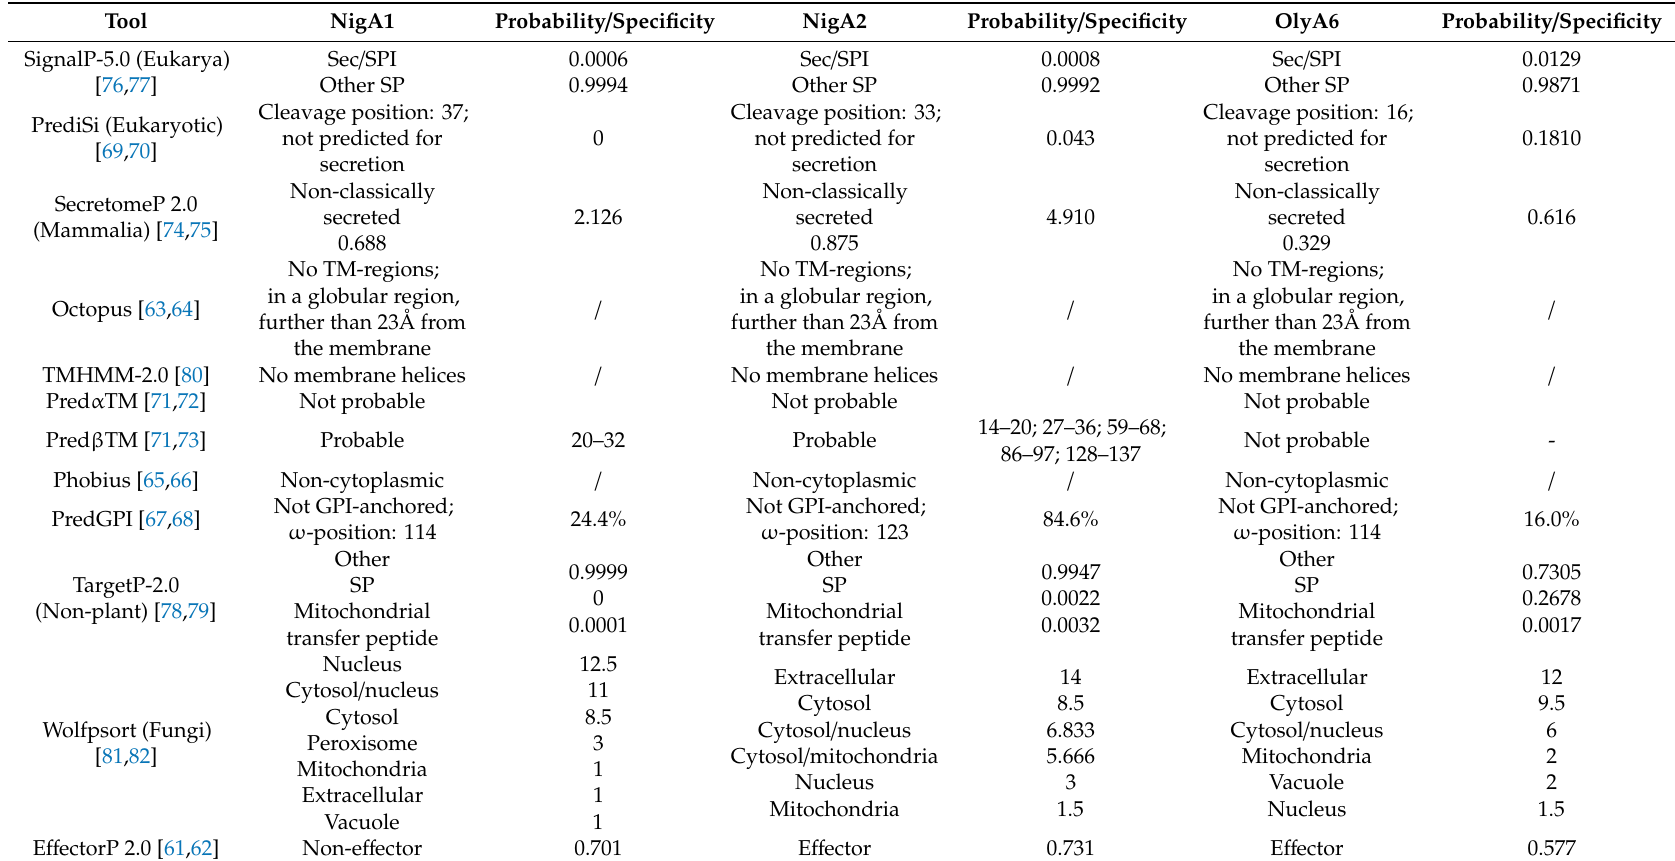
Table 3. Sequence analysis of aegerolysin proteins by web prediction